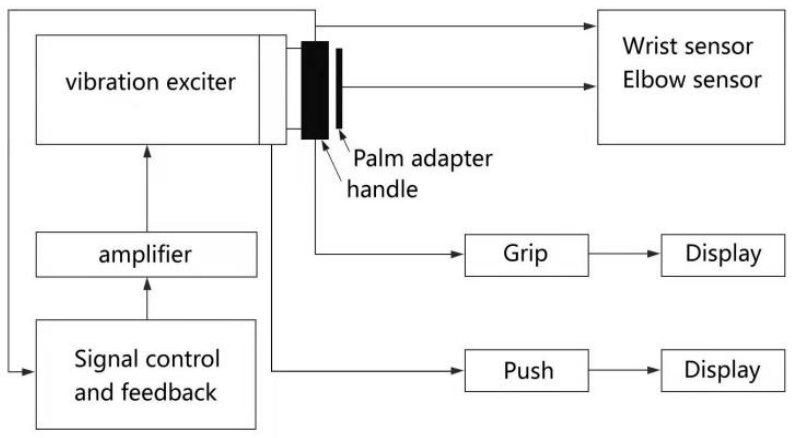
Figure 2. Schematic diagram of the experimental setup.